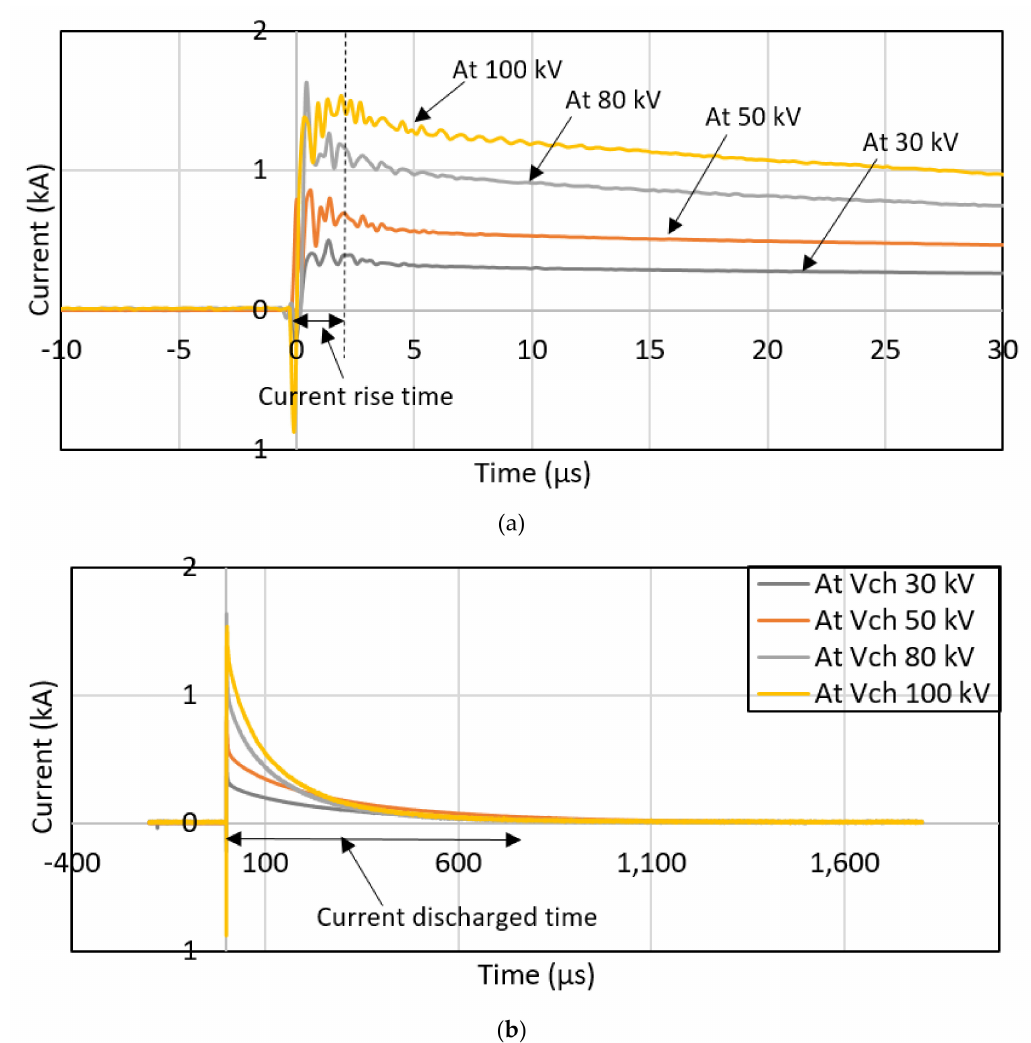
Figure 3. Current traces of GE 5, at various charging voltages of positive impulse polarity: ( a ) short time scale, ( b ) long time